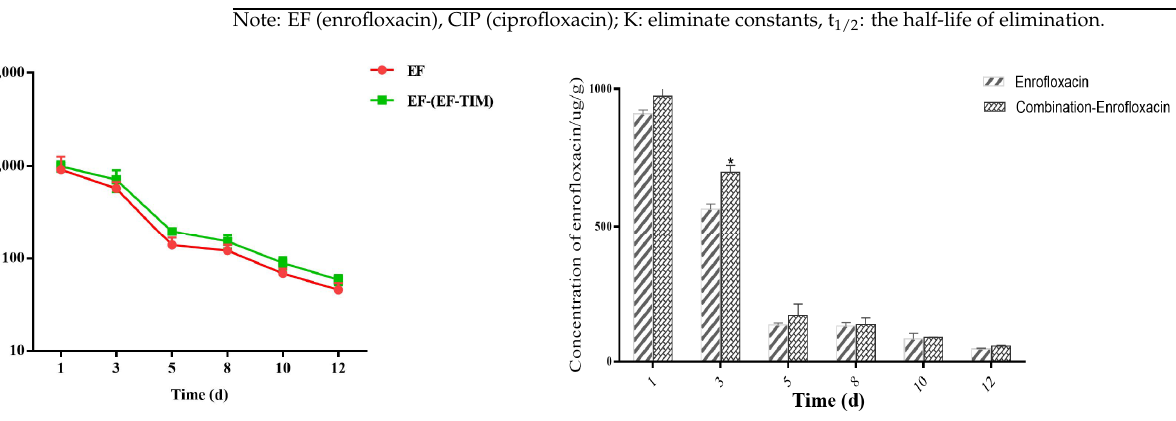
Figure 3. Time-lapse graphs of CIP in eggs. Note: CIP (ciprofloxacin), EF (enrofloxacin), TIM (tilmicosin). The data were expressed as mean ± SD. * p < 0.05 denoted statistical significance. 3.3. Residue Elimination Characteristics of TIM in Eggs Tables 9–11 show the residual concentrations of TIM in the whole egg, yolk, and egg white at different points in time. The TIM single administration group: The peak concentrations of TIM in the egg samples were 68.97 ± 19.08 μg/kg on the 3rd day of administration (Table 9). The peak concentration of TIM in samples was 72.59 ± 17.59 μg/kg on the 1st day after drug with- drawal. On the 3rd day after stopping the medication, the concentration of TIM decreased to 57.12 ± 13.06 μg/kg. The TIM content was 41.01 ± 10.51 μg/kg and 24.87 ± 8.26 μg/kg on the 8th and 10th days after drug withdrawal, respectively, and the TIM content was 12.95